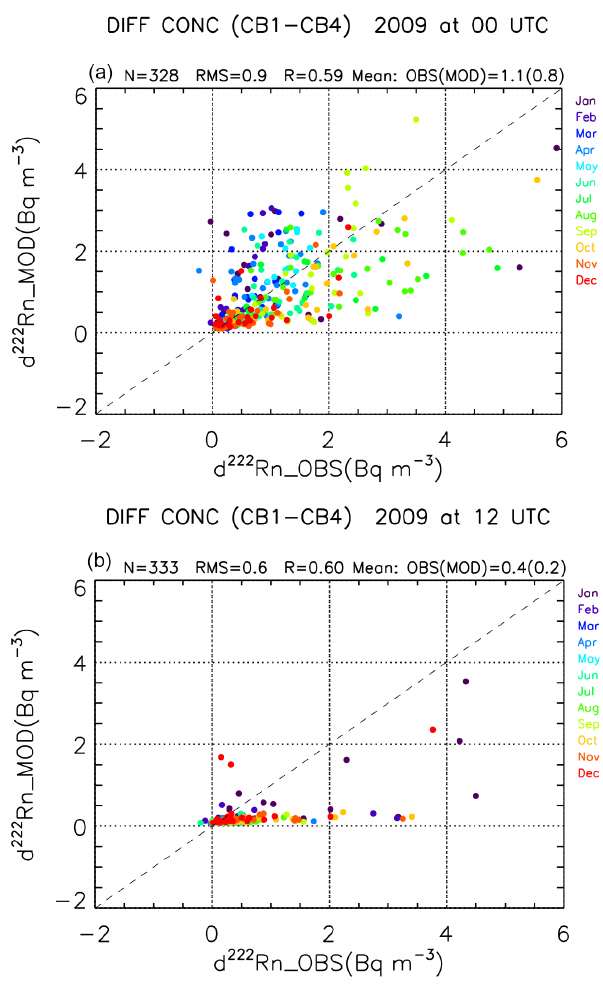
Figure 12. Correlation plots between the simulated (“MOD”) and observed (“OBS”) vertical 222 Rn activity concentration gradients (difference between 20m (CB1) and 200m (CB4) at Cabauw at 00:00UTC (top) and 12:00UTC (bottom)). Model simulations us- ing InGOS emissions (FI_CT) are shown. Each colour indicates the month at which the data are